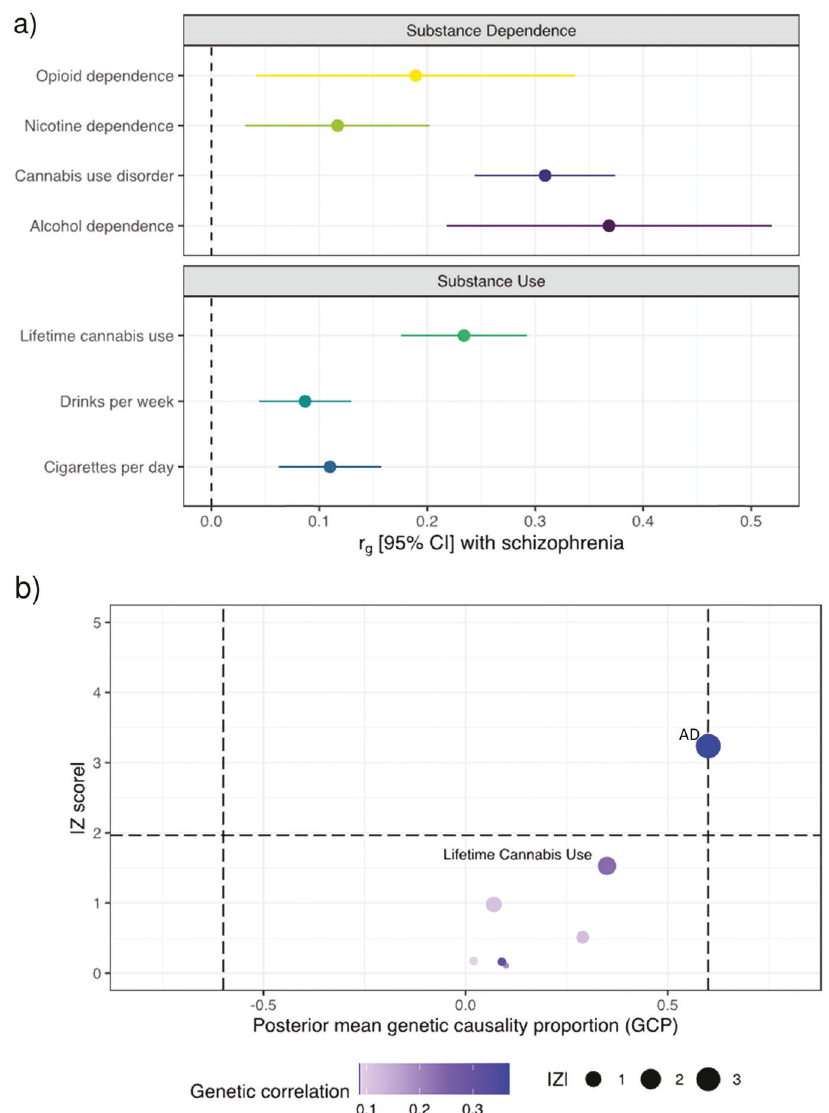
Fig. 1 Genetic relatioships between substance use disorders and schizophrenia. a Genetic correlation forest plot between schizophrenia and SUDs (AD, CUD, ND, and OD), r g calculated using linkage disequilibrium (LD) score regression. b Latent causal variable (LCV) model to test for partial causality with posterior mean genetic causality proportion (GCP) estimates of each SUD on schizophrenia. Absolute magnitude of the Z -score relates to the test of whether the posterior mean GCP estimate is signi fi cantly different than zero. The vertical line represents genetic causality, with a posterior mean GCP > 0.6 implying partial genetic causality of trait 1 and trait 2, and inverse for GCP < − 0.6. The horizontal line represents an absolute Z -score of ~1.96, which is nominal uncorrected signi fi cance ( P < 0.05) for a test of whether GCP value is signi fi cantly